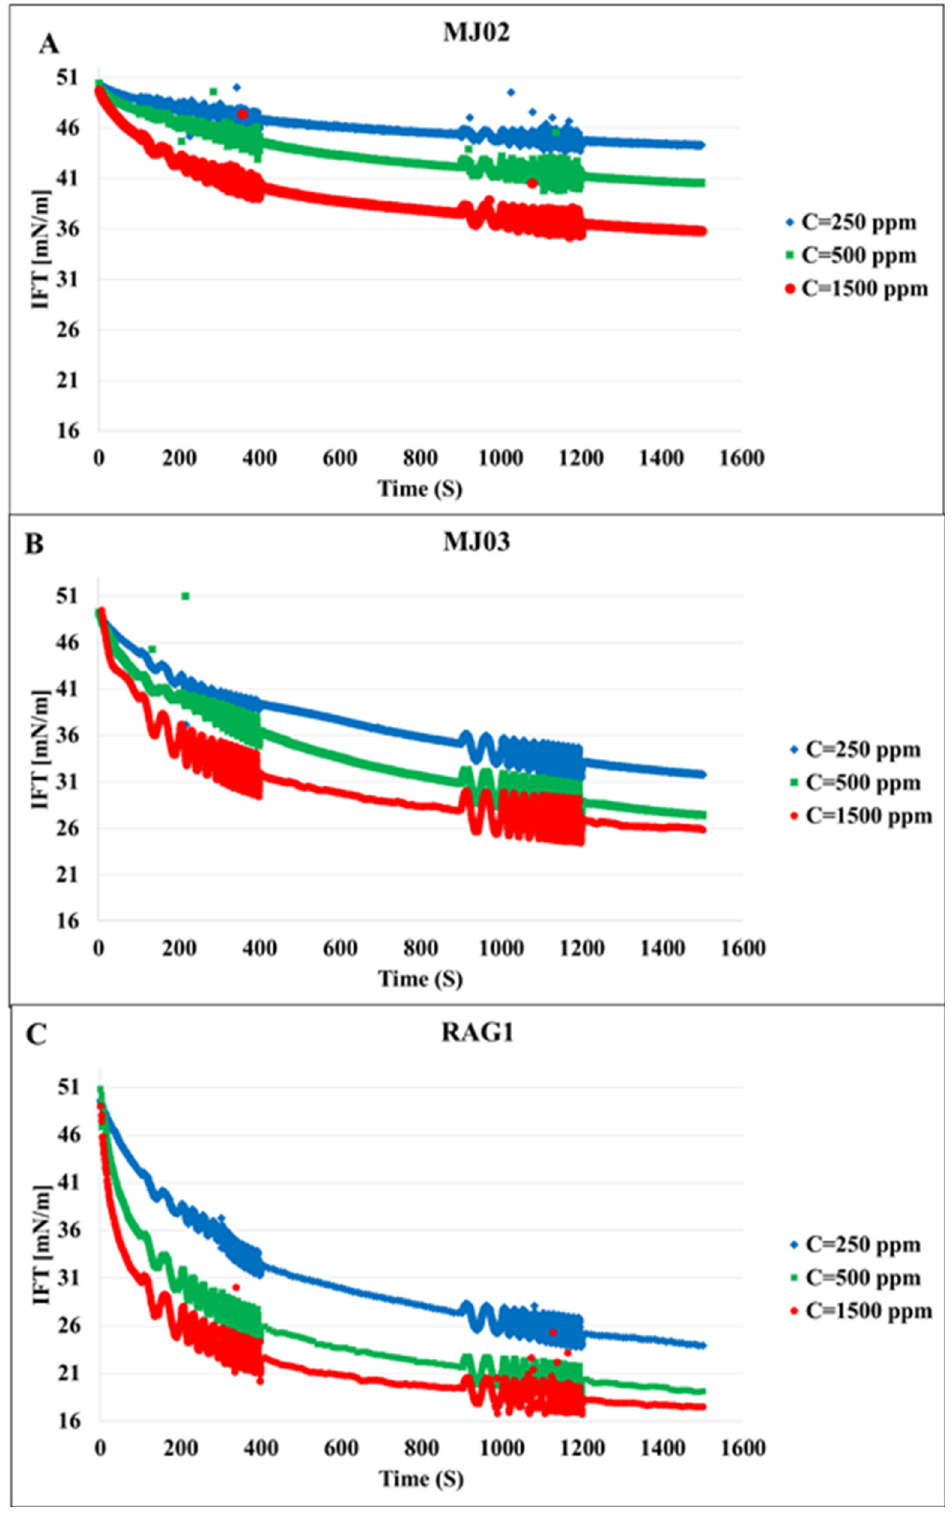
Figure 1. Dynamic interfacial tension for three different bacteria samples at different cell concentra- tions (given in the insert in ppm). ( A ), MJ02; ( B ), MJ03; ( C ), RAG1.